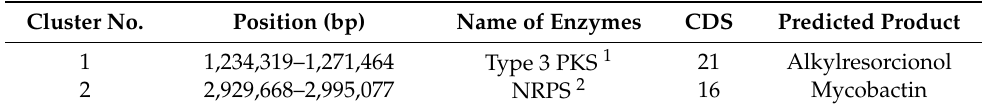
Table 5. Secondary metabolite clusters in JIII-386 with ≥ 60% gene similarity to antiSMASH database. Cluster